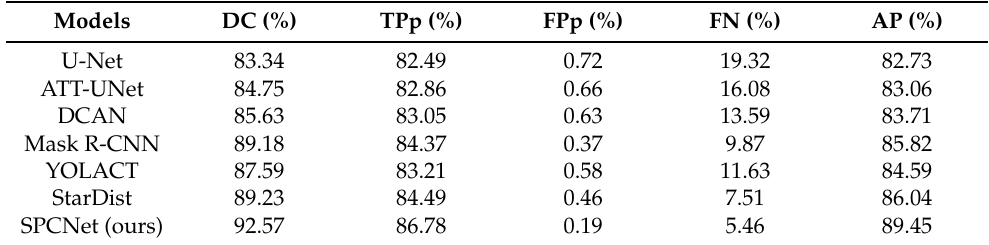
Table 4. Performance comparison between our model and the classical segmentation models on the TCC